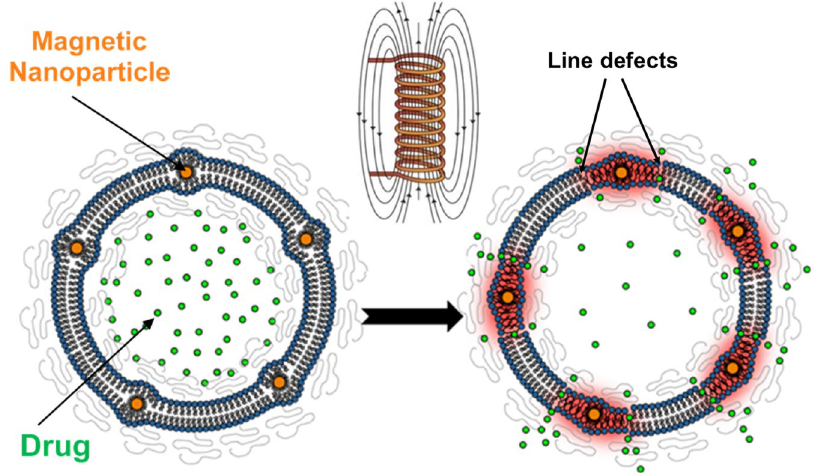
Figure 1. Local heat generation from SPION through Néel’s relaxation produces a line defect in the membrane separating melted (liquid) from solid domains.